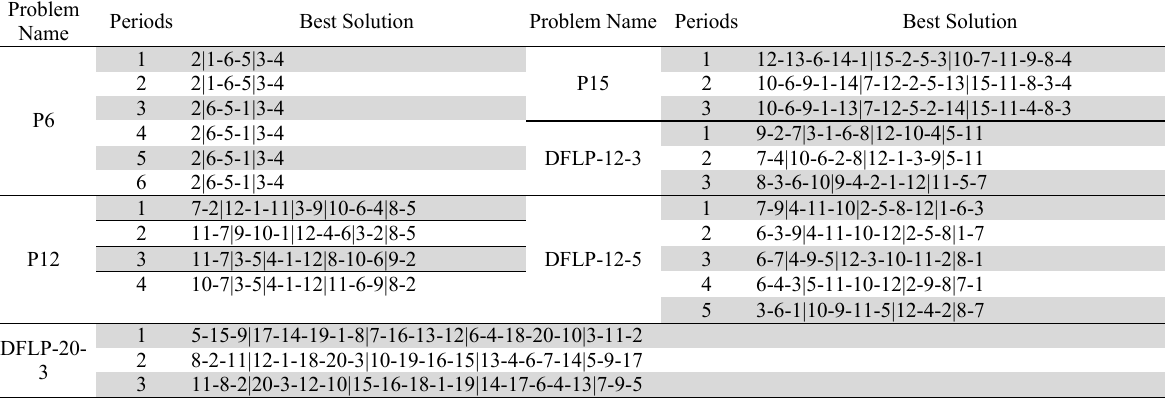
Table 4 Best solution found by the proposed SA heuristic for the non-FBS based test problems